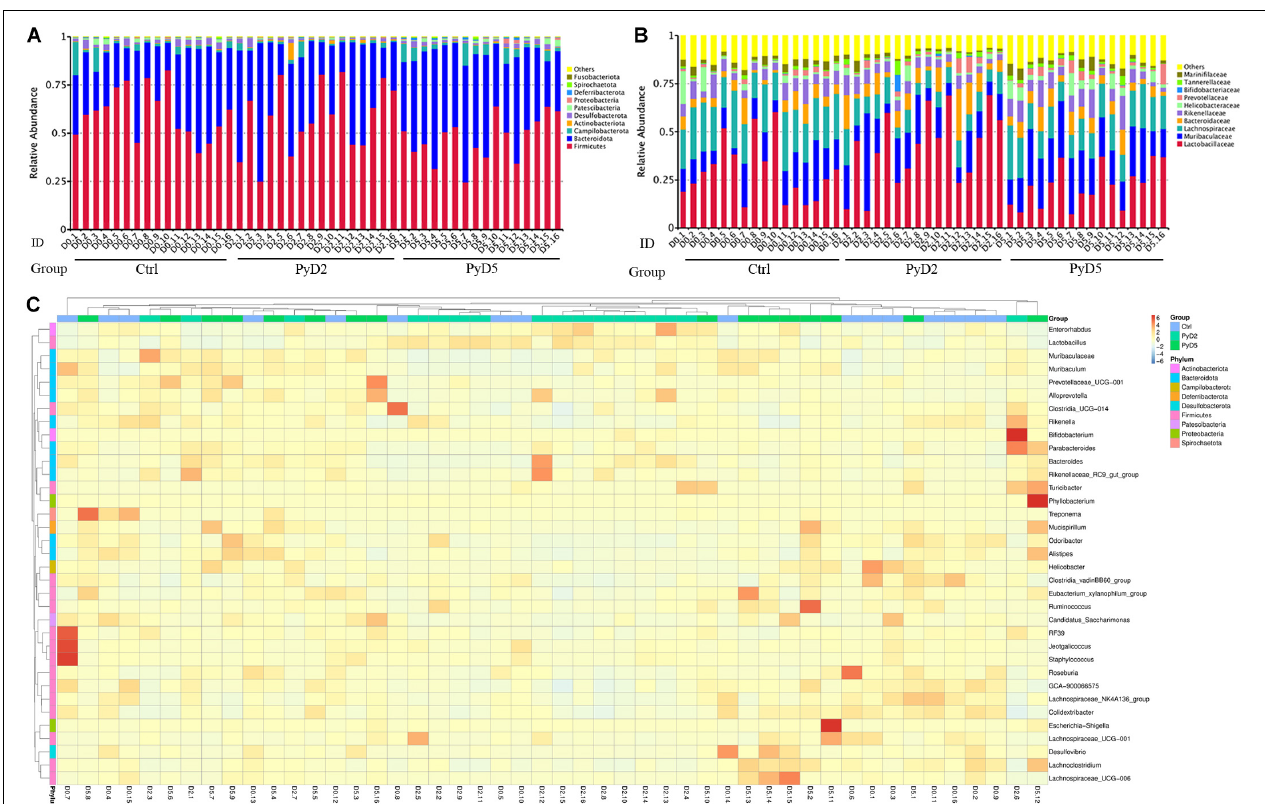
FIGURE 3 | Changes in the gut microbiota composition. Relative abundance of fecal bacterial phyla and families existing in the BALB/c mice. Each bar represents the top 10 abundant phyla and families, whereas “Other” were obtained from low abundant and unclassified OTUs. Sample names represent samples described in Table 1 . (A) Variations in the gut microbiota composition at the phylum level. (B) Variations in the gut microbiota composition at the family level; (C) Taxonomic heatmap of the three groups at the genus level. Typical relative g10 abundance of diversified genera present in the Ctrl, PyD2, and PyD5 groups. Each column represents a unique subject.